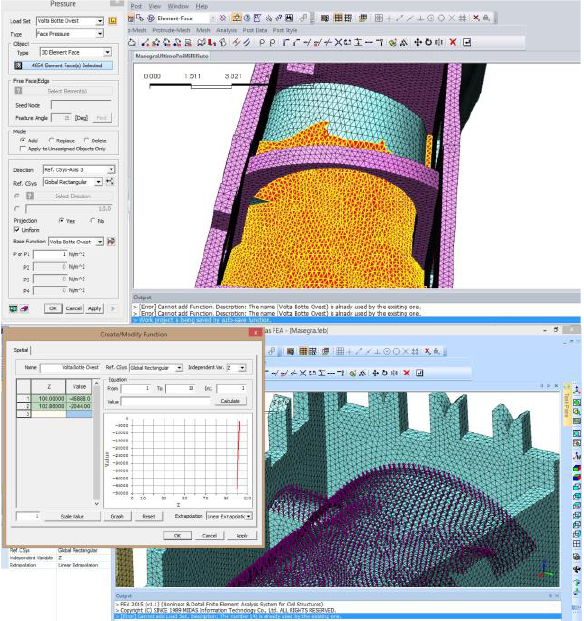
Fig. 7. Assignment of dead load on a barrel vault by using the faces of the mesh.